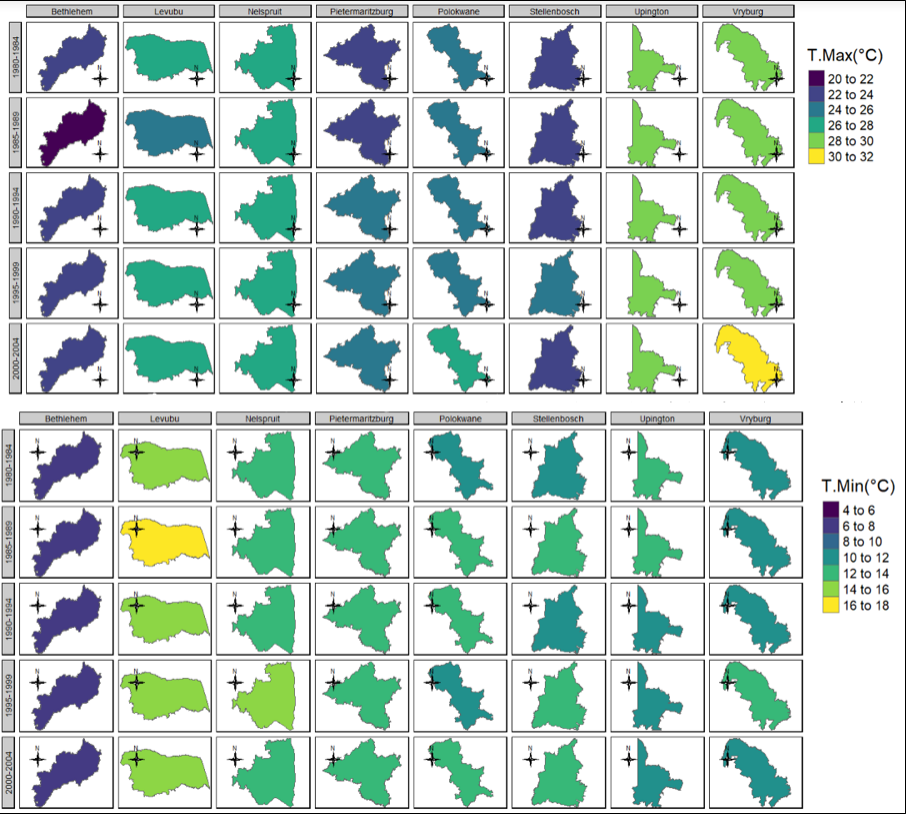
Figure 8. Temperature changes at 5-year intervals at the meteorological stations in South Africa.